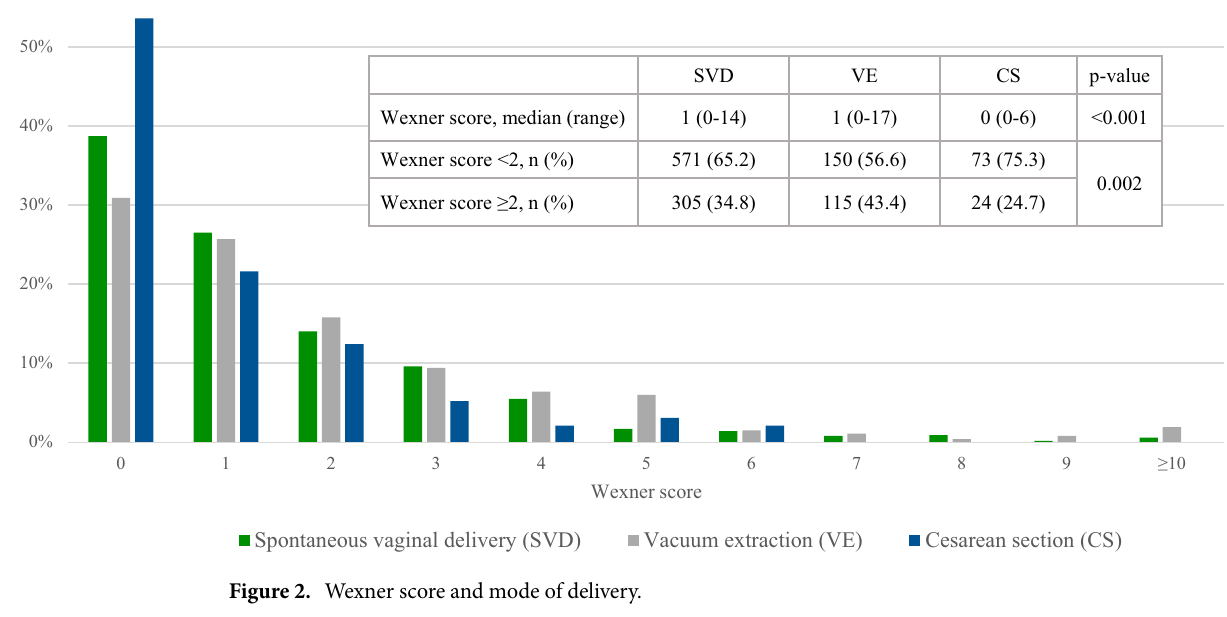
Figure 2. Wexner score and mode of